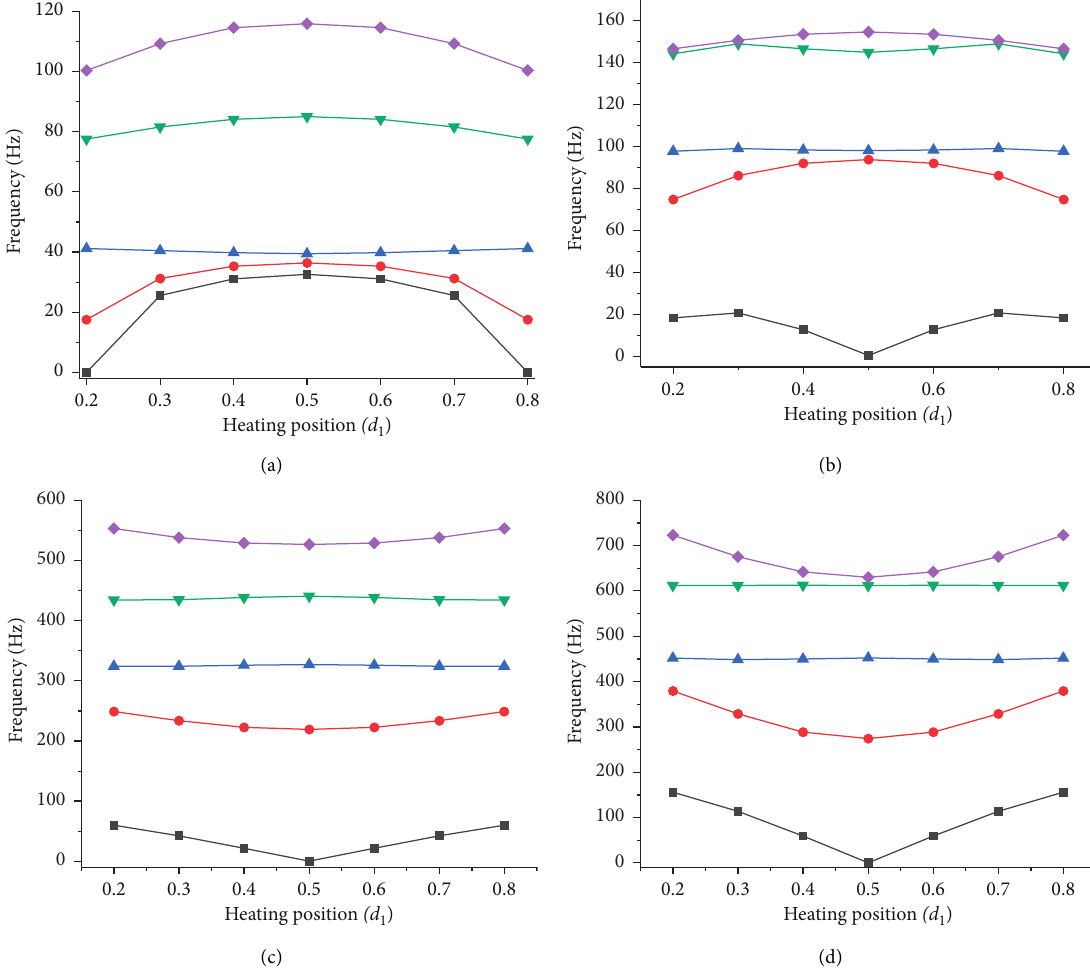
Figure 9: Vibration frequencies of composite laminated plates with different heating positions: (a) k k � 4 e 5Pa and K t